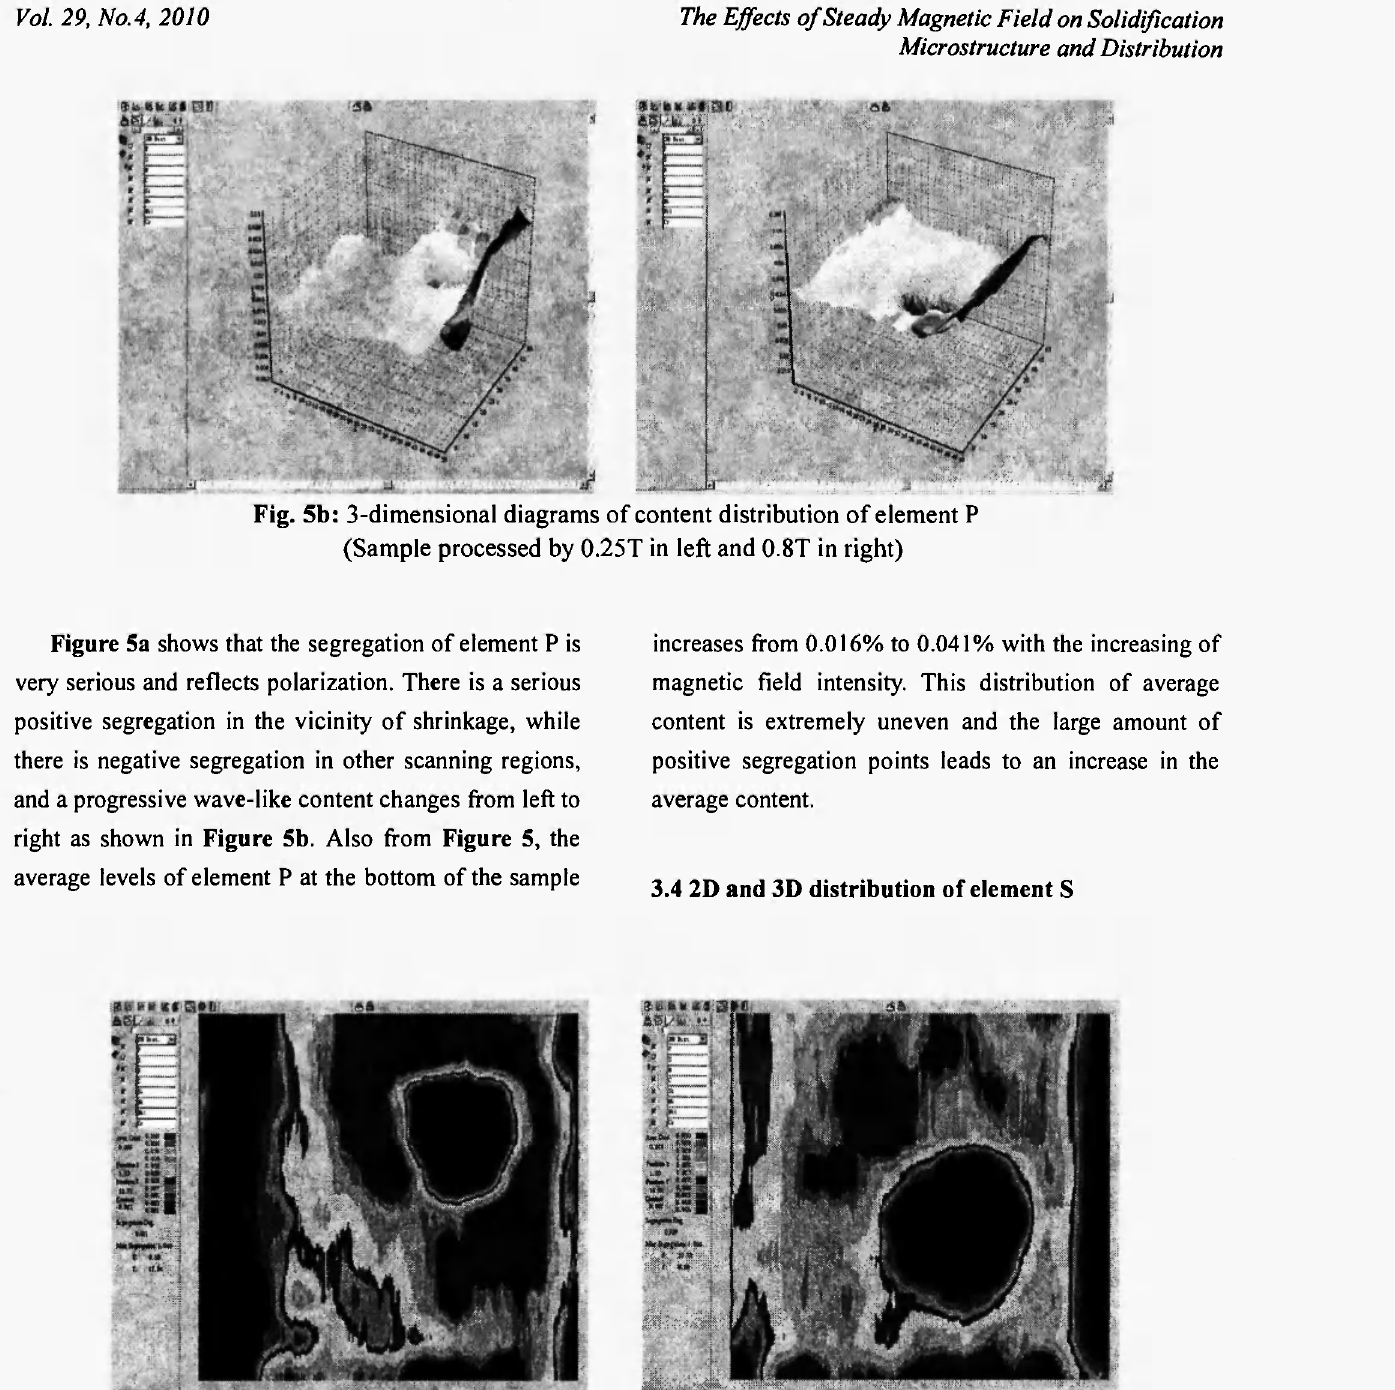
Fig. 6a: 2-dimensional diagrams of content distribution of element S (Sample processed by 0.25T in left and 0.8T in